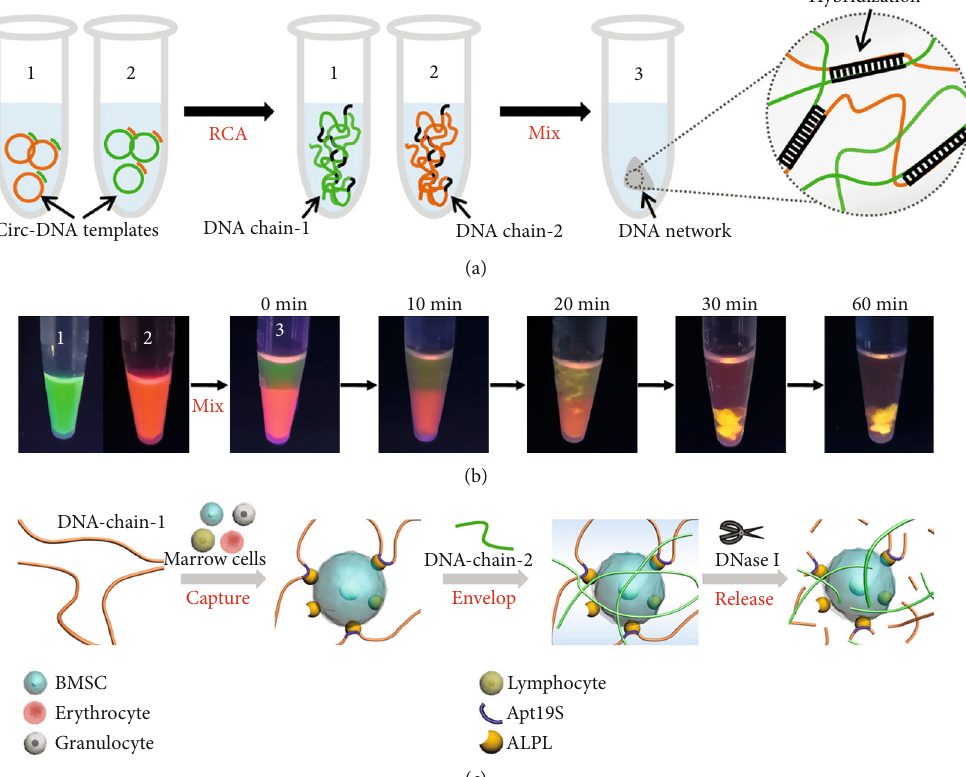
Figure 5: (a) It is possible to generate ultralong DNA chains using circular DNA templates. The strategy of elongation employed is a double rolling circle ampli fi cation (double RCA). Using two partially complementary DNA templates, the ultralong chains are able to hybridize with each other after mixing. (b) The use of stained DNA chains allows the observation of the hybridization process after being mixed. (c) The template DNA also contained aptamers that bind to a speci fi c surface membrane protein (ALPL) of marrow cells. The authors designed a mechanism of capture and release of stem cells using the aptamer-containing ultralong DNA hydrogel and DNases for degradation of the matrix. These fi gures have been reproduced with permission from the American Chemical Society